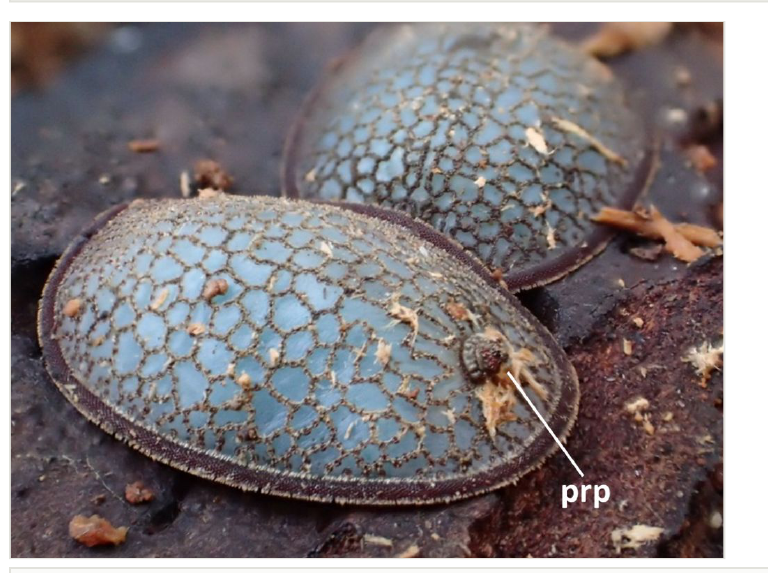
Figure 3. A posterior respiratory process (prp) was observed on a Microdon katsurai